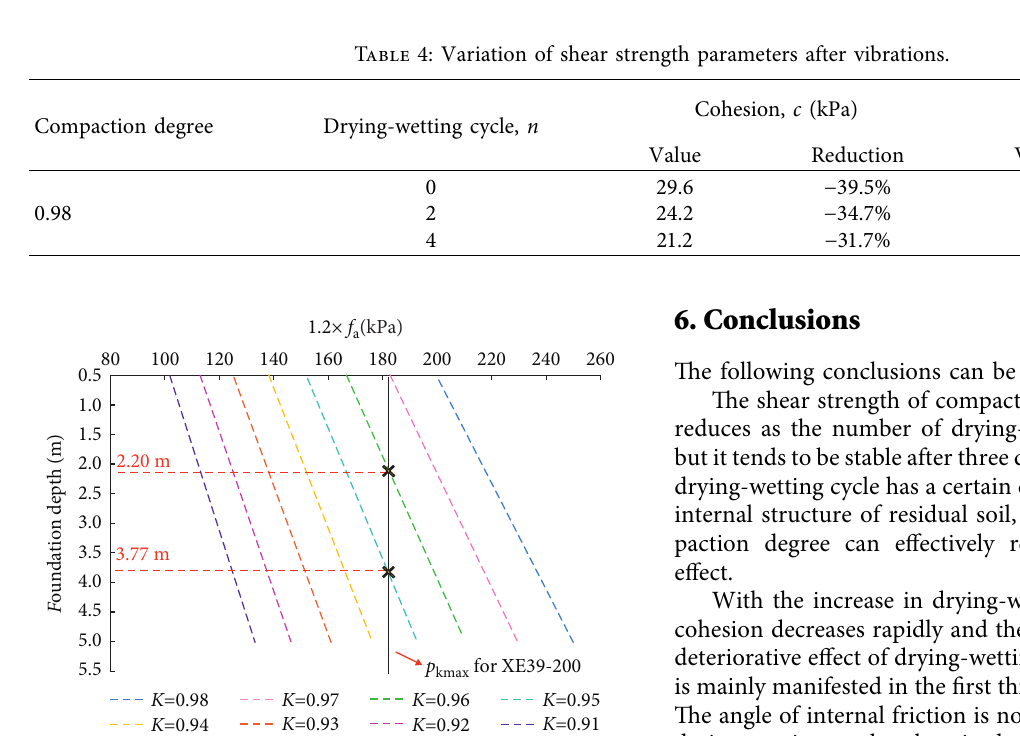
Figure 13: Relationship between the bearing capacity and em- bedded depth of